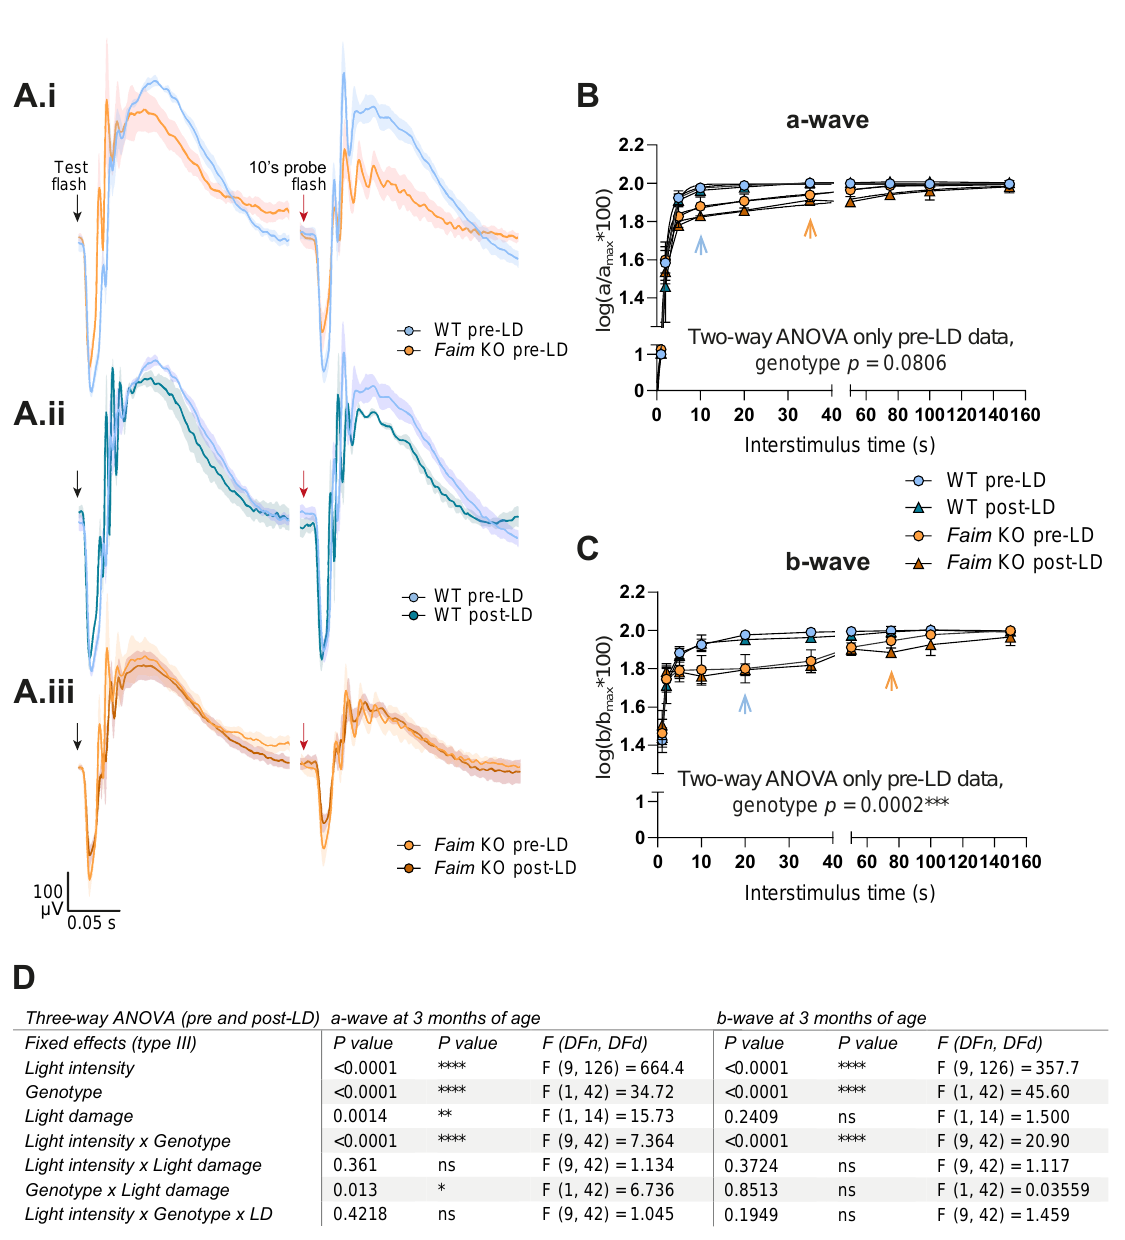
Figure 4. Faim KO mice show a great delay in dark adaptation in comparison to WT mice at 3 months, but few differences are found after LD. ( A ) ERG waves at 1.5 log cd·s/m 2 after test flash (left, black arrow) and after 1 0′ s probe flash (right, red arrow). Data are plotted as the mean (solid line) and SEM deviation (shaded area) of each condition. ( A.i ) ERG recordings from WT and Faim KO mice before light damage. ( A.ii ) ERG recordings from WT mice before and after LD. ( A.iii ) ERG recordings from Faim KO mice before and after LD. ( B , C ) Graph representing the delay in dark adaptation found in the mixed a-wave ( B ) and b-wave ( C ) of Faim KO mice in comparison to WT mice. Data are represented as mean and SD and as log(a/a max *100) or log(b/b max *100) to interstimulus time, where “a max ” and “b max ” are the a- and b-wave after the test flash, and “a” and “b” are the a- and b-wave after the probe flash. Statistical analysis was performed using two-way ANOVA when comparing only pre-LD data, and three-way ANOVA when comparing all data, including pre-LD and post-LD results. ( D ) Three-way ANOVA results of mixed a- and b-wave dark adaptation analyses. N = 6–7 mice for pre-LD analyses, and n = 4 for post-LD analyses. * p < 0.05, ** p < 0.01, *** p < 0.005, **** p < 0.001.